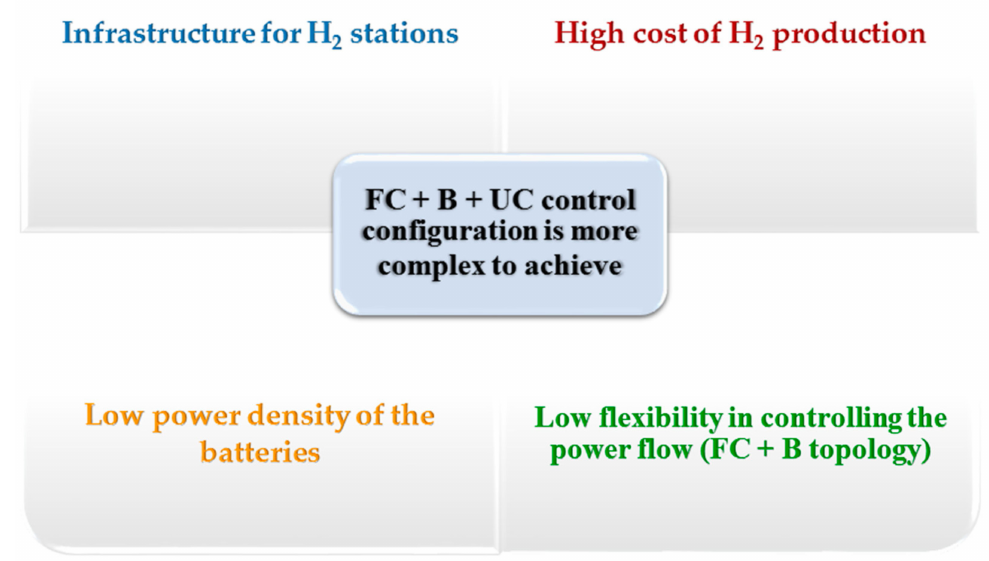
Figure 11. The main challenges in adopting Fuel Cell (FC) technologies as automotive propulsion